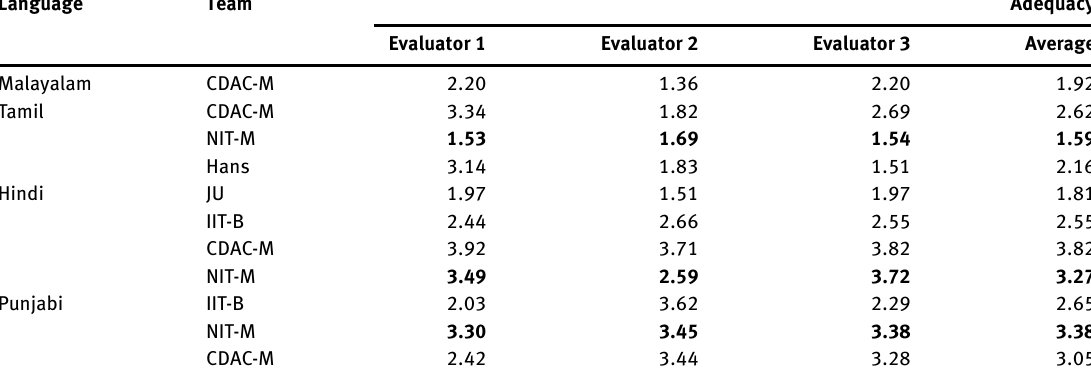
Table 2: Adequacy Table. Language